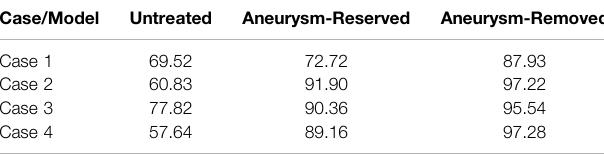
TABLE 3 | Percentage (%) of blood fl ow rate at the aortic outlets.